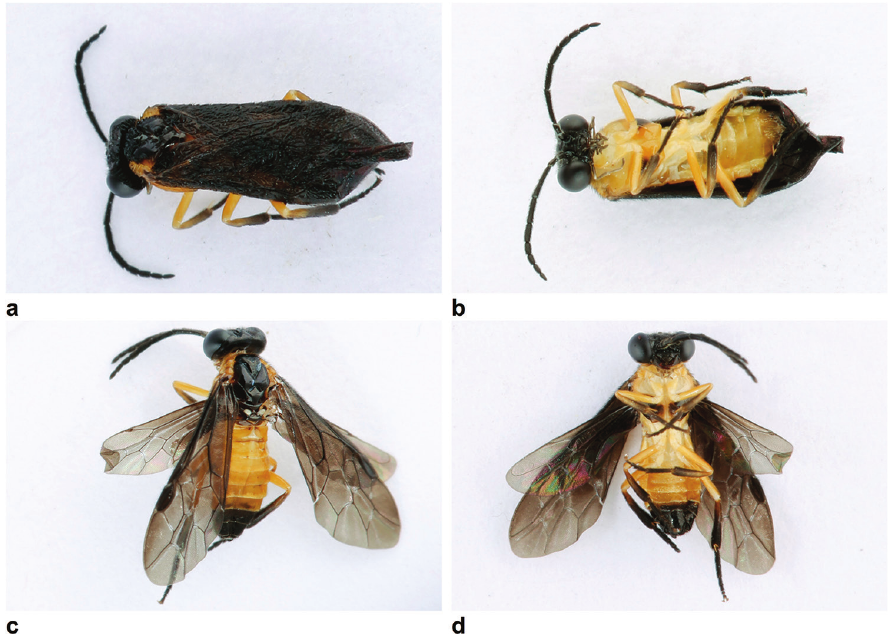
Figure 19. Proselandria alvina . a, b Female (P4221.A), body length 5.0 mm c, d male (P4214.C), body length 6.0 mm. a, c Dorsal views b, d ventral views.